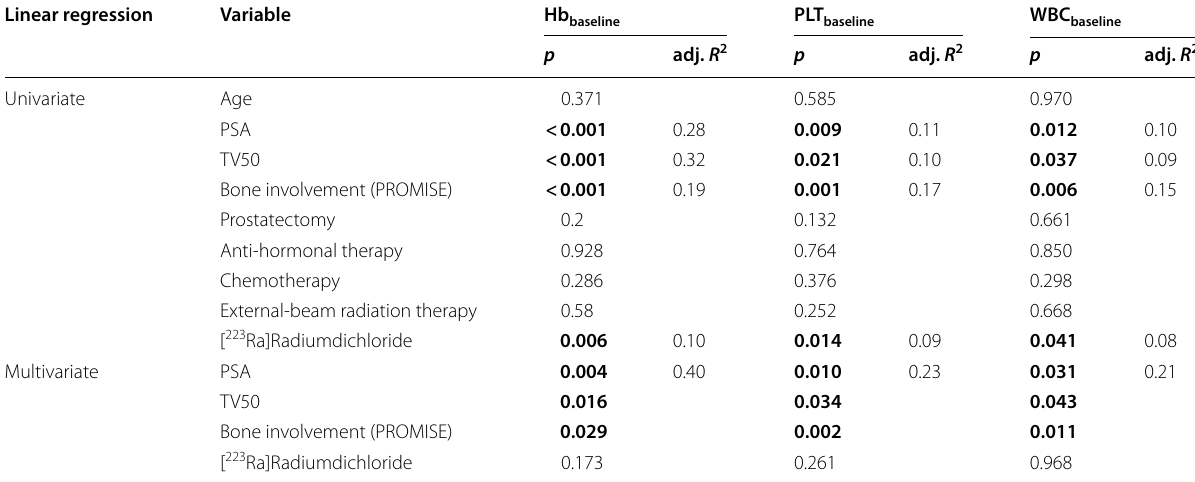
All variables with statistically significant results (bold) correlate inversely with haematological parameters (Hb, PLT, WBC) at baseline; Hb haemoglobin = concentration, PLT platelet count, WBC white blood cell count, PSA prostate-specific antigen, TV50 whole-body tumour volume assessed by semi-automated = = = = analysis of PSMA PET/CT acquisitions utilising percentage thresholding (50% of maximal lesion SUV)